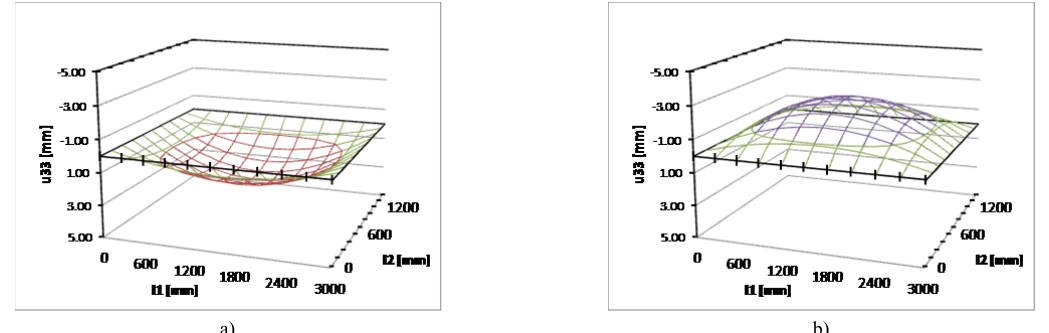
Fig. 10 Deflection of IGU glass panes (1500 x 3000 mm) with aluminum spacer, a) ext. pane, b) int. pane